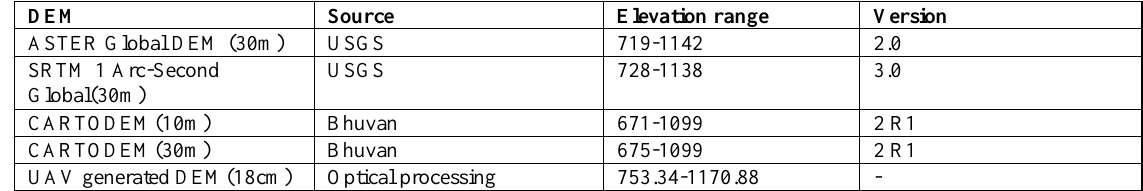
Table 1: DEMs used along with source, elevation and